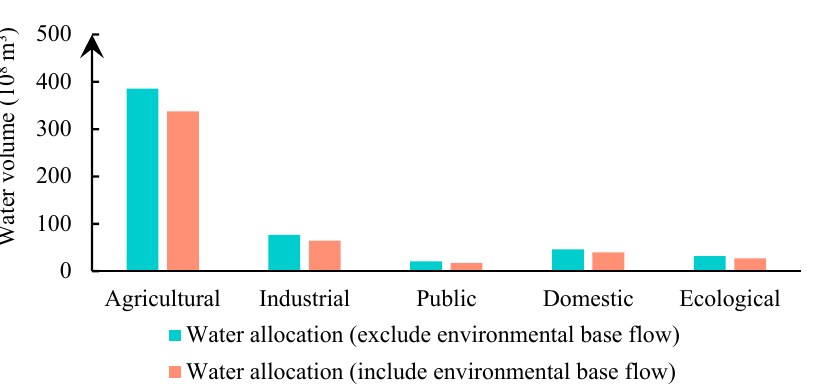
Figure 16. Comparison of water allocation with or without environmental base flow.